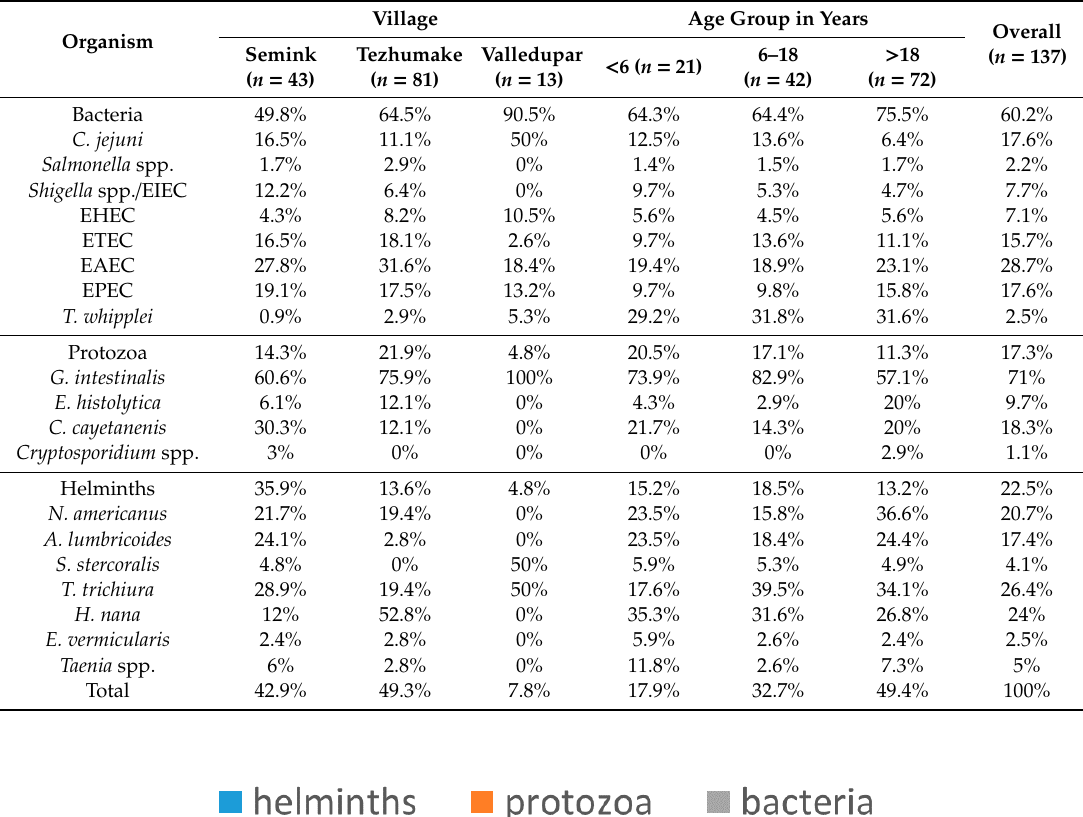
Table 2. Gastrointestinal organisms identified in stool samples by species groups stratified by village and age groups. C. jejuni= Campylobacer jejuni, EIEC=enteroinvasive E. coli,